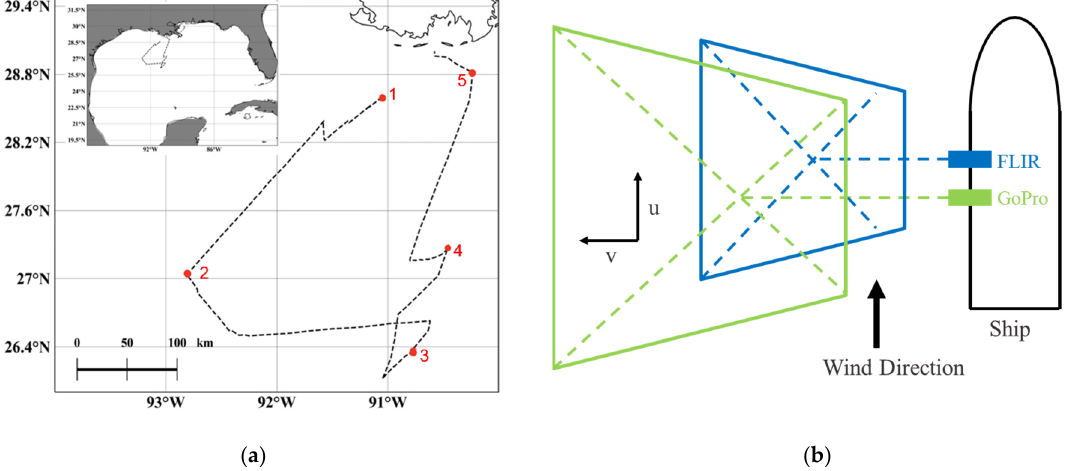
Figure 1. ( a ) Route of the cruise (red dots denote the stations); ( b ) schematic of cameras fields of view: the FLIR (blue) is an IR camera, the GoPro (green) is a visible